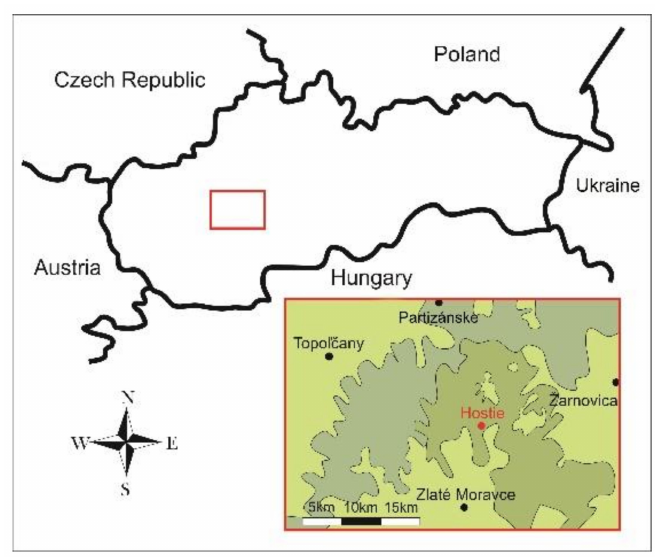
Figure 1. Schematic illustration of the Hostie experimental locality near Zlat é Moravce in the Slovak Republic. Nitrianska pahorkatina—Hills and the Tribeˇc mountain region are in the western part, the Pohronsk ý Inovec mountain is in the east, and the Žitavsk á upland area is in the southern portion [24].